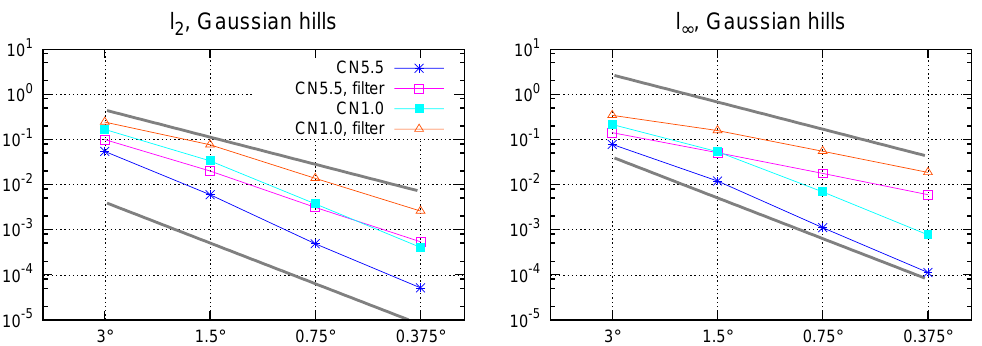
Fig. 4. Convergence plots for ‘ 2 (first column) and ‘ ∞ (second column), respectively, computed with CSLAM with Gaussian hills initial conditions. The keys with “CN5.5” and “CN1.0” refer to simulations using a non-dimensional time step of T/ 120 and T/ 600, respectively. The keys with the word filter in them refer to simulations using a shape-preserving filter. The upper and lower heavy lines on each plot correspond to the slopes of second- and third-order convergence rates, respectively. Fig. 5. Convergence plot for ‘ 2 computed with CSLAM with cosine bells initial conditions. The keys are as in Fig. 4. The heavy line is ‘ 2 = 0 . 033 and is used to define “minimal” resolution. based on point values (parcels) control volumes for which the point values are representative must be defined. Note that 375 the ‘control volumes’ should span the entire domain without overlaps or ‘cracks’ between them. For infinite resolution (continuous case) and a non-divergent flow, ‘ f ( τ,t ) is invariant in time: ‘ f ( τ,t = 0) = ‘ f ( τ,t ) = 100 for all τ . At finite resolution, however, the filament di- 380 agnostic even for an exact scheme should not necessarily be preserved since the solution must be truncated to the discrete grid. That said, usually the numerical truncation errors are much larger than the grid truncation error at least at moder- ate resolutions. 385